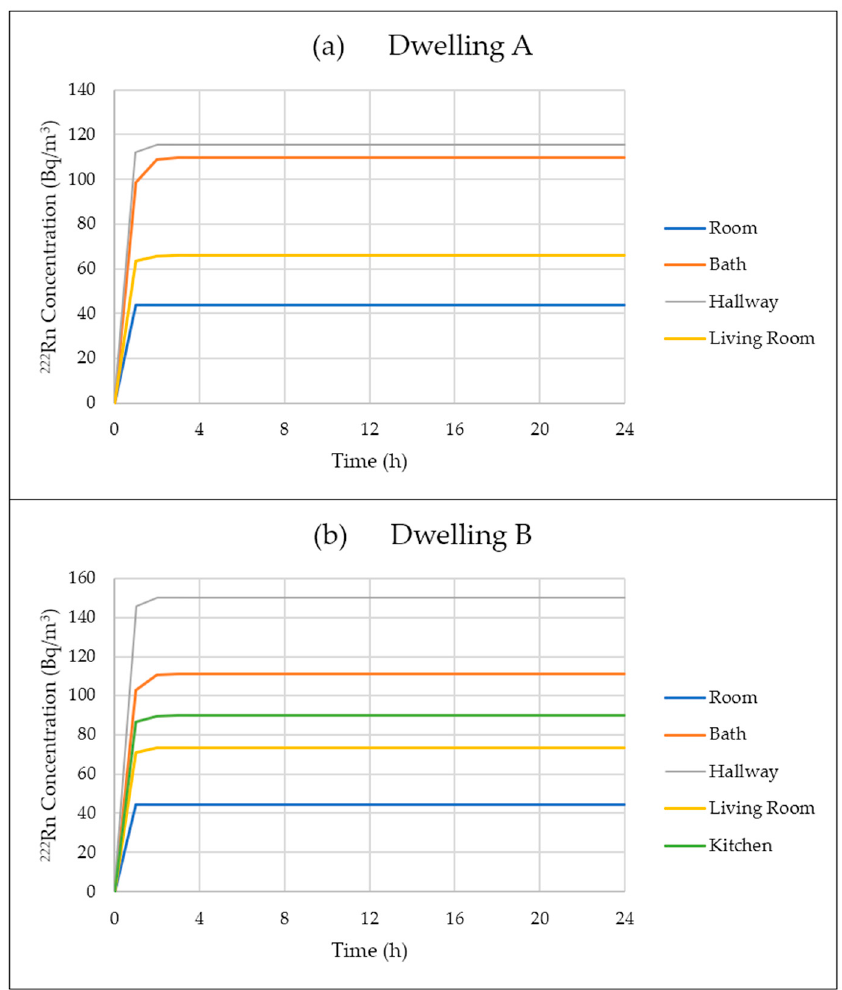
Figure 3. Evolution of radon concentration in ( a ) dwelling “A” and ( b ) dwelling “B”, considering the parameters from Table 1. The results were obtained from simulations using the CONTAM software following the methodology described in the paper.